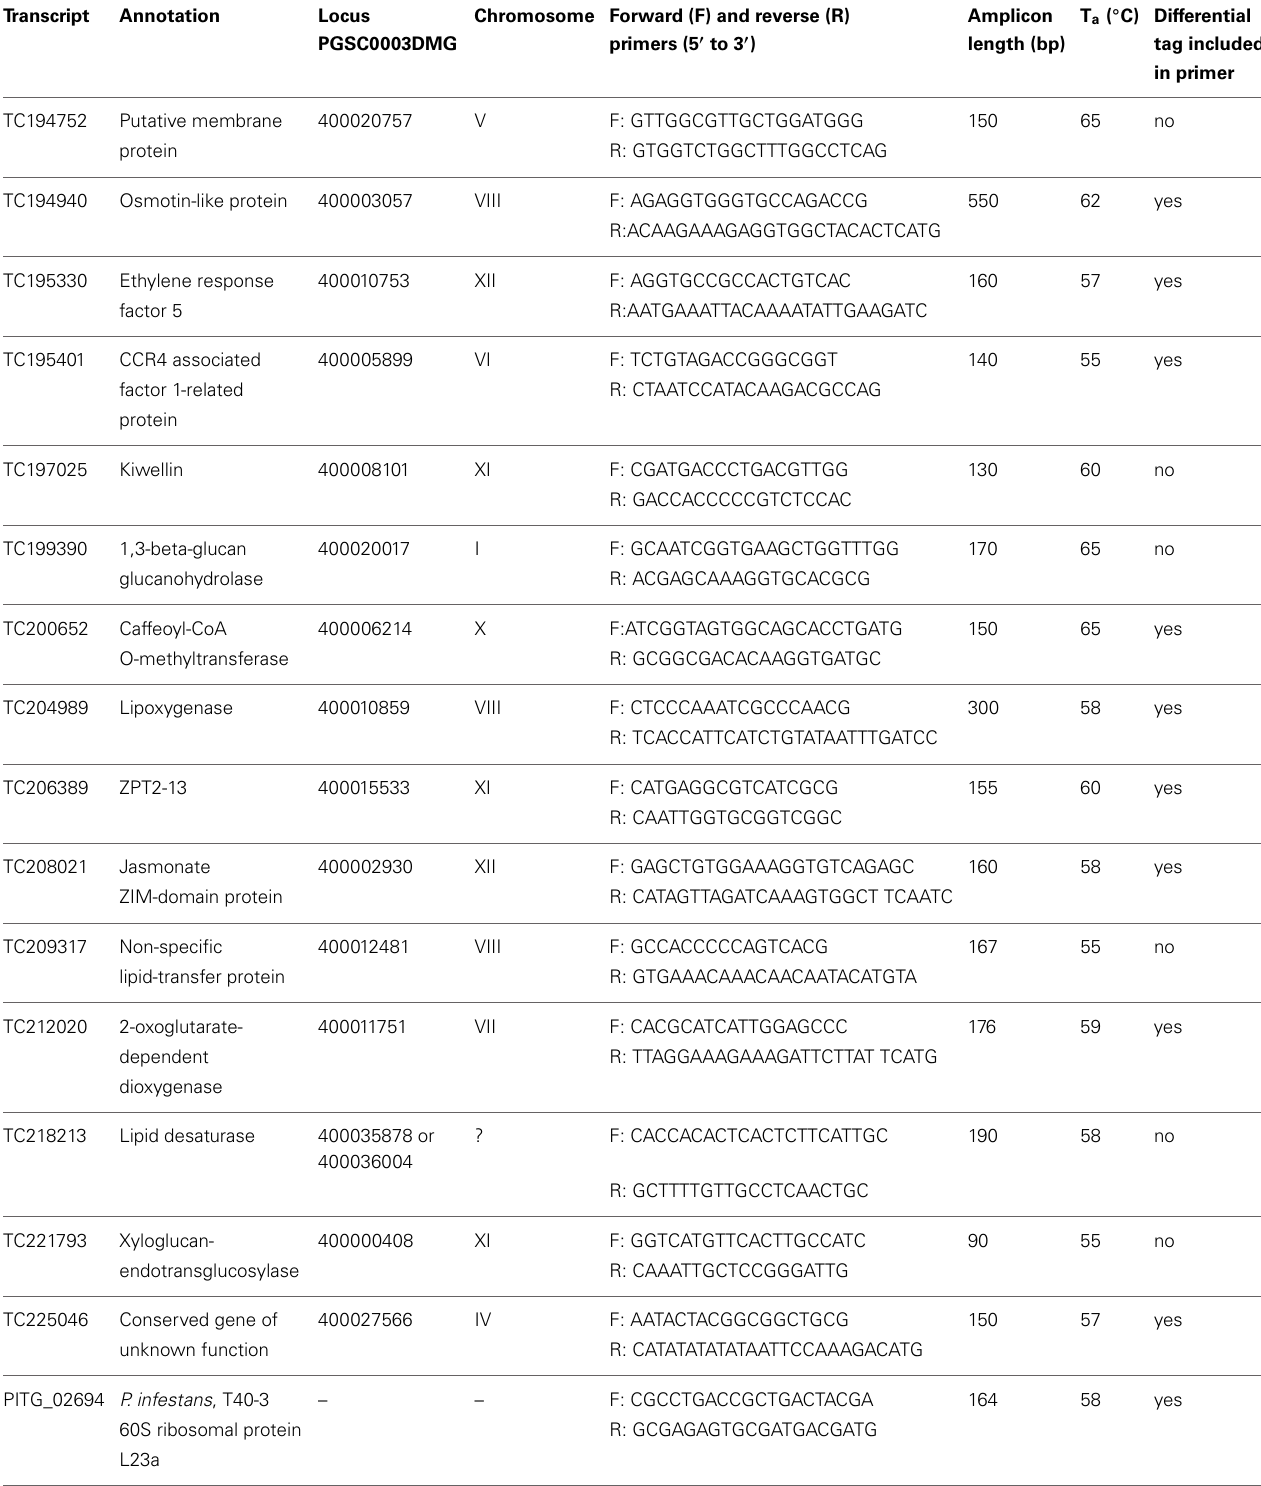
Table 2 | Primers used for semiquantitative